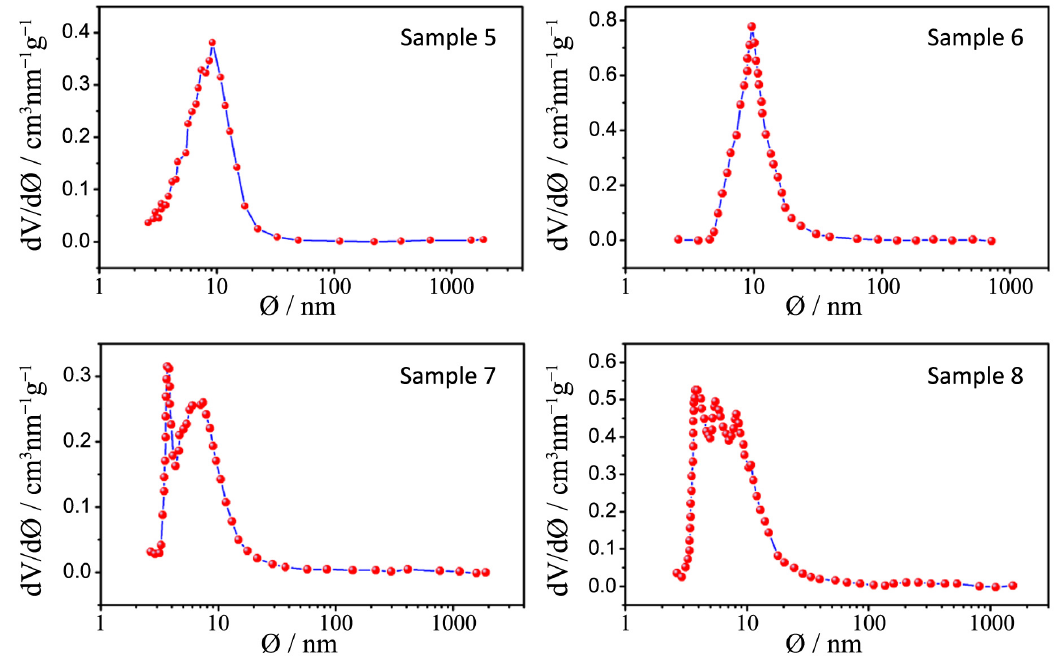
Figure 9. Pore size distribution plots for samples 5–8.